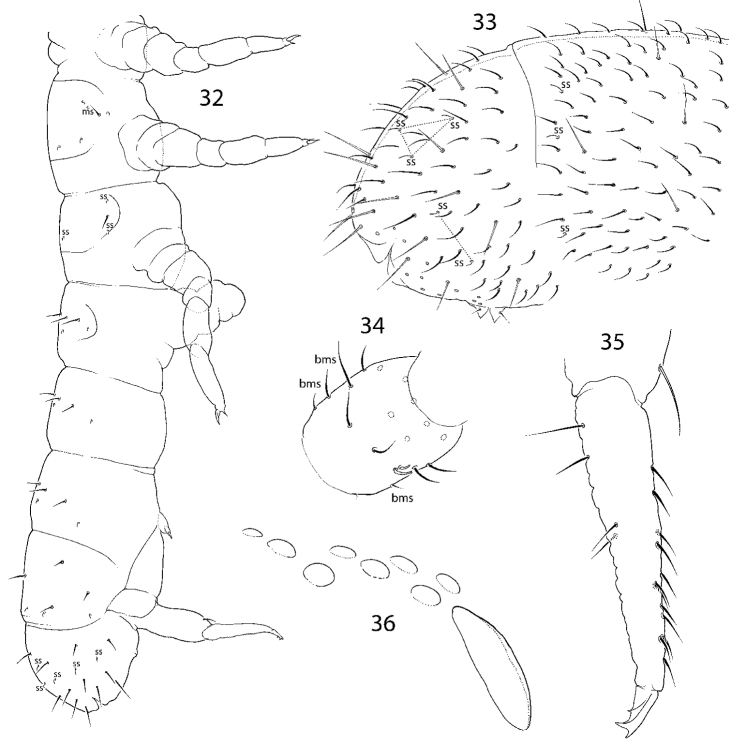
C.
inflatus sp. nov. 32 macrochaetotaxy and s-ms-pattern 33Abd. IV and fused Abd. V and VI 34Ant. I 35 dens, lateral view 36 ocelli and PAO. Abbreviations: ss s-chaeta, bms basal ms-chaeta, msms-chaeta.